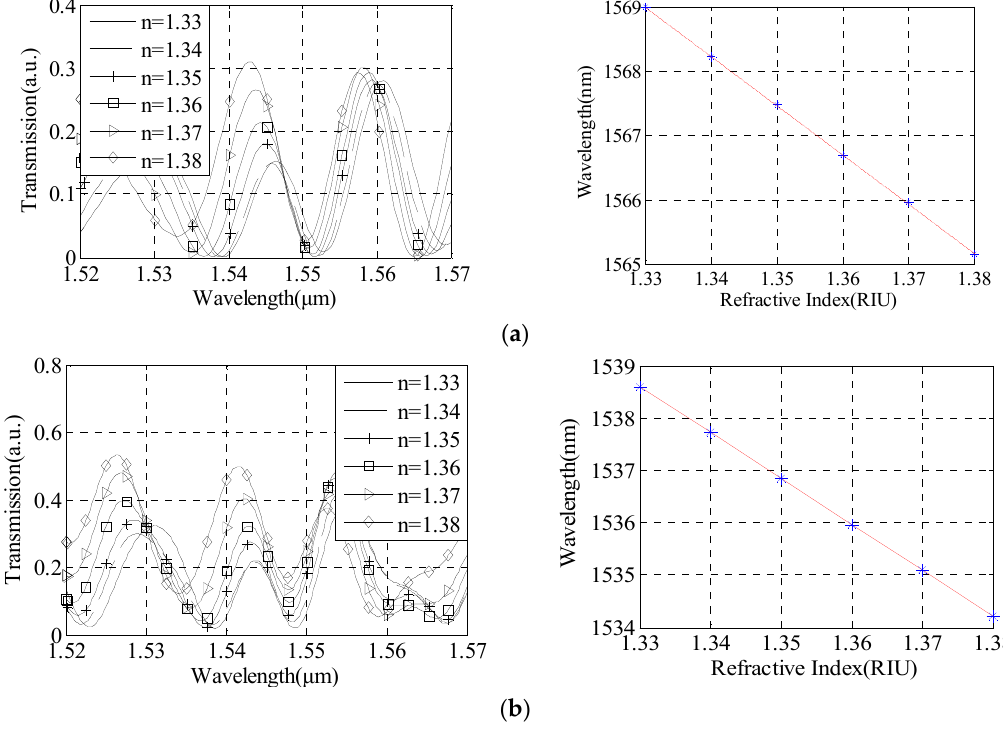
Figure 5. Refractive index measurement sensitivity analysis with different distance of the tapers. ( a ) L = 4 cm; ( b ) L = 6 cm.